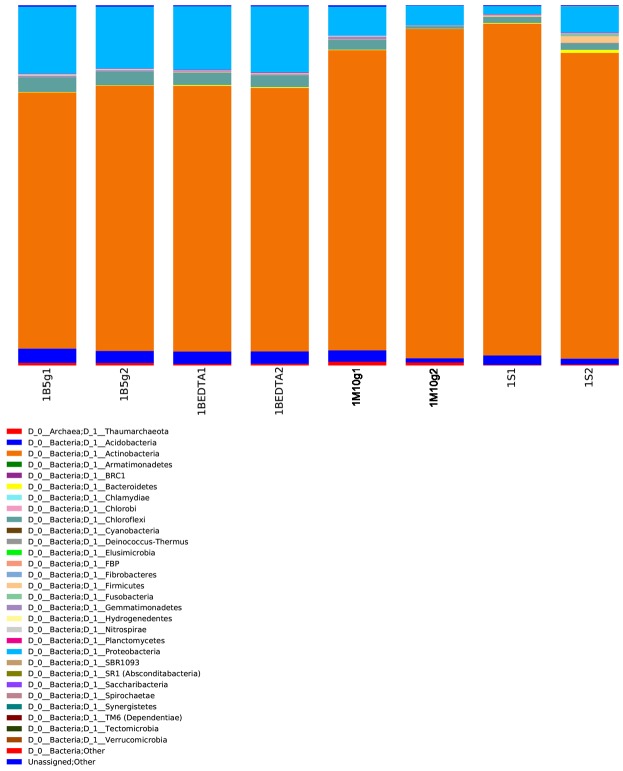
Comparison of microbial community (phylum level) from matrix-surrounded subterranean.Centrosaurus bone, bone scrapings, and adjacent mudstone matrix. There are two replicates per sample. Sample ID’s are as in Appendix 1—table 2: B = matrix surrounded subterranean Centrosaurus bone core (surface scraped prior to powdering; 5g indicates that this sample was analysed using the DNeasy PowerMax Soil kit), BEDTA = matrix surrounded subterranean Centrosaurus bone core (EDTA demineralised, surface scraped prior to powdering), M = adjacent mudstone matrix of subterranean Centrosaurus bone (10g indicates that the samples were analysed using the DNeasy PowerMax Soil kit), S = Surface scrapings from matrix-surrounded subterranean Centrosaurus bone. Both the bone core data and the EDTA demineralized bone core data are technique replicates deriving from single DNA extractions of each sample category, while both the mudstone matrix and surface scrapings data columns are from two separate DNA extractions of each sample category (Appendix 1—table 25).